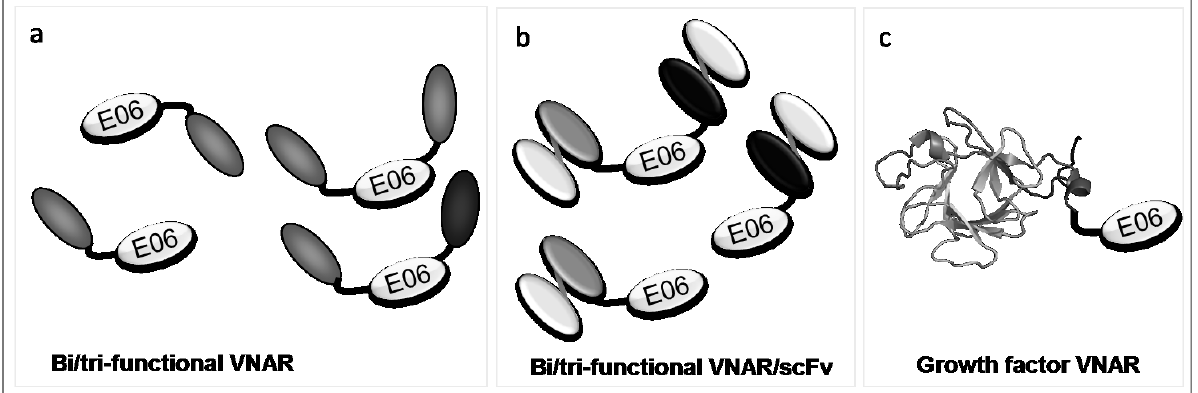
Figure 3. Validated formats for half-life extension ( a ) N-terminal, C-terminal and dual terminal fusions of E06 with partner VNAR domains; ( b ) N-terminal, C-terminal and dual terminal fusions of E06 with partner scFv domains; ( c ) E06 growth factor fusion